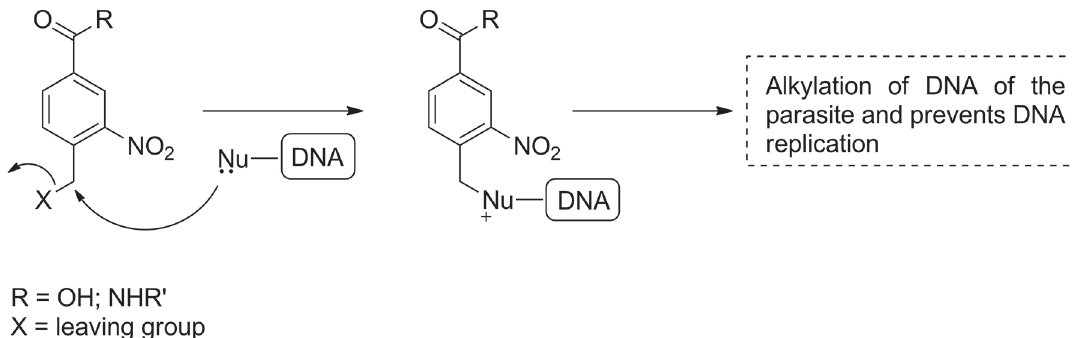
FIGURE 4 – Mechanism of action proposed for the ortho-nitrobenzyl derivatives